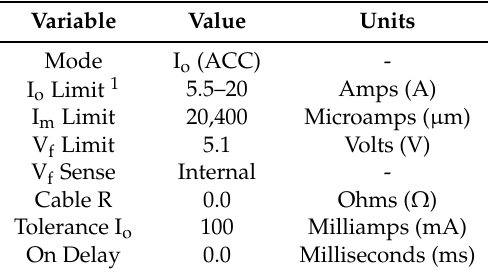
Table 2. LaserSource 20A 4320 Set Up Values.